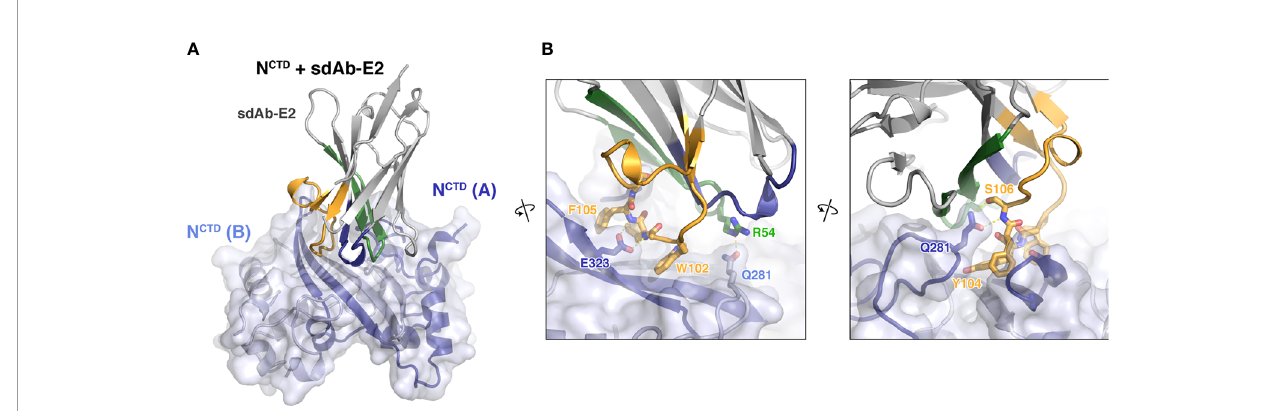
FIGURE 3 | Structure of an sdAb targeting the SARS-CoV-2 N protein CTD. (A) Structure of sdAb-E2 (with CDR1, CDR2, and CDR3 colored blue, green, and orange as in Figure 1C ) bound to the N CTD dimer (light blue/dark blue). (B) Two close-up views of the N CTD